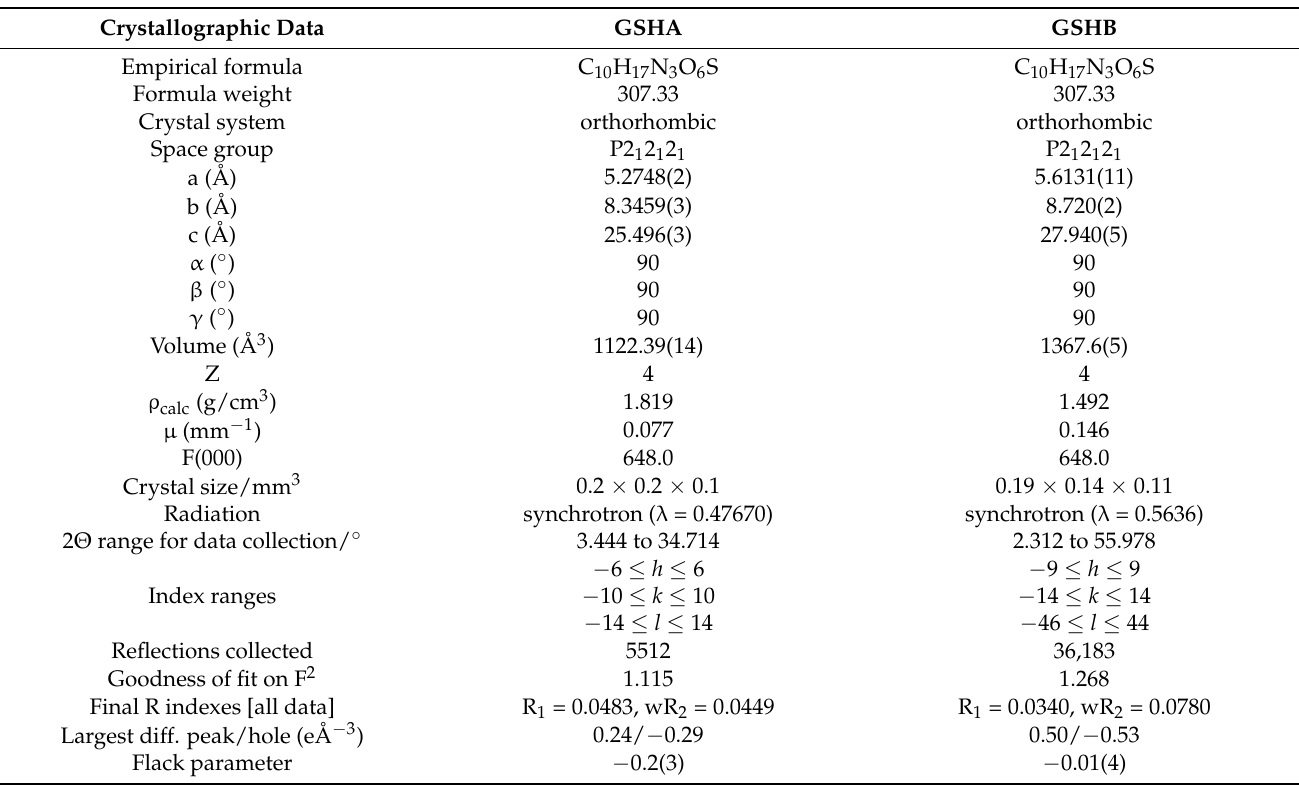
Table 1. Crystallographic data and structure refinement parameters for GSHA and